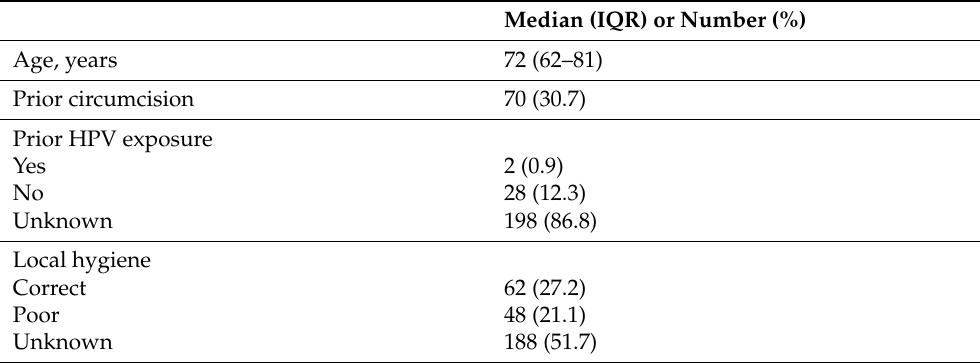
Table 1. Patients’ Baseline Characteristics ( n =